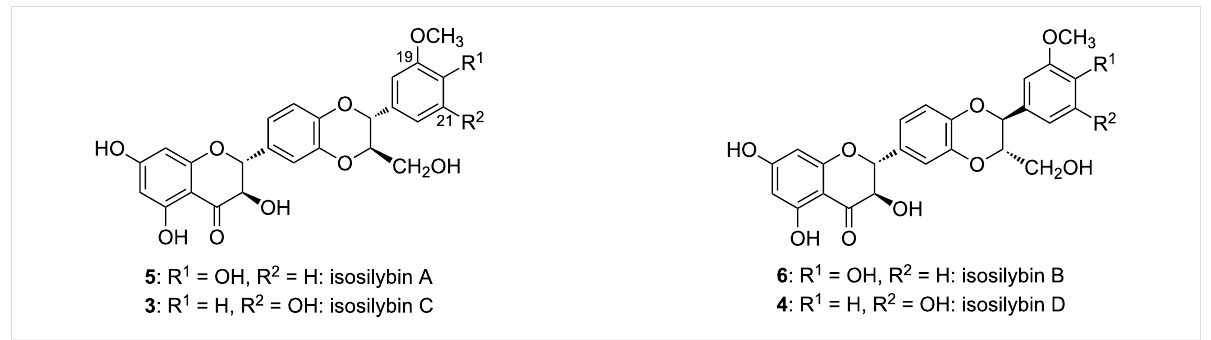
Figure 2: Isosilybins occurring as minor components of